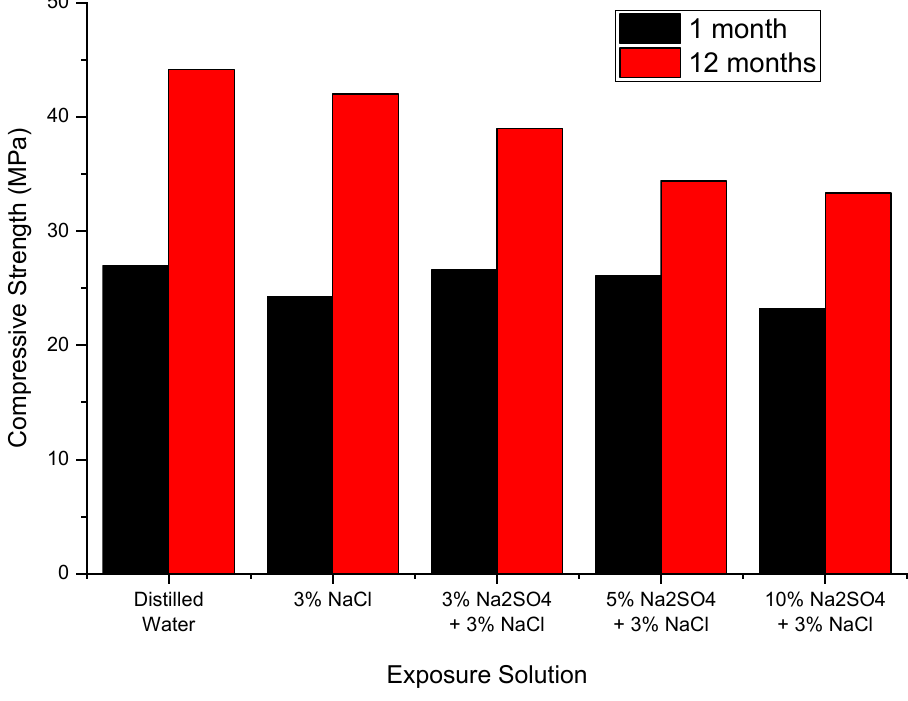
Figure 7. Effects of combined chloride–sulphate exposure on compressive strength of concrete [18].